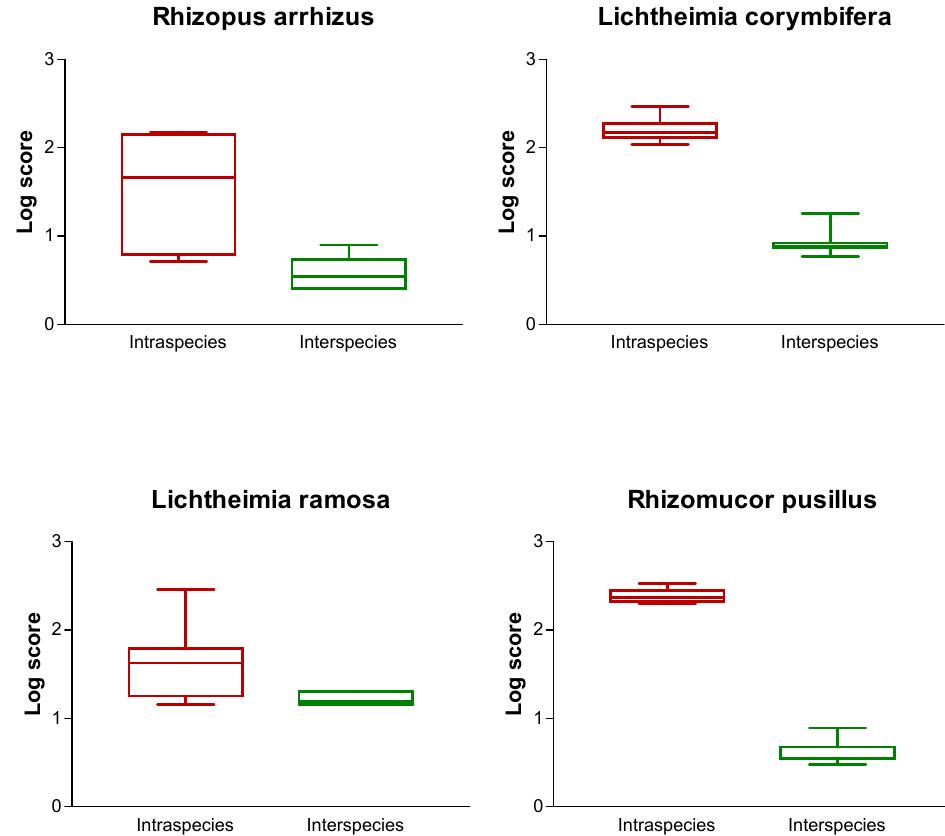
Figure 2. Plot of log-score values obtained for the isolates, belonging to four species, were used for the accuracy test of the database. On each graph, the left panel plots the log-scores values obtained for the isolates belonging to the same species (as a marker of intraspecies variability), and the right panel plots the log-scores values obtained for isolates belonging to different species (as a marker of interspecies variability).